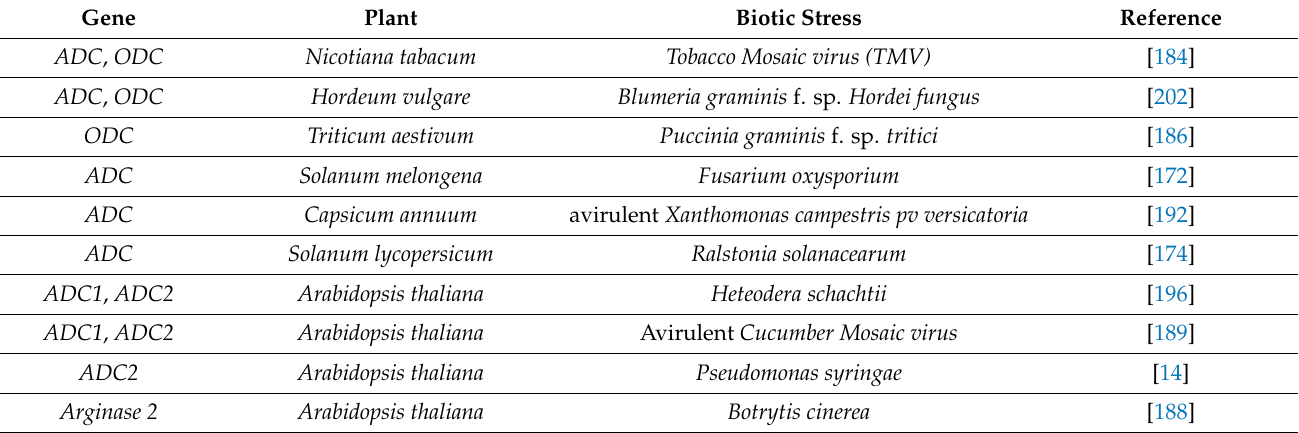
Table 2. Increased expression of ADC and ODC genes in response to biotic stress in different plant